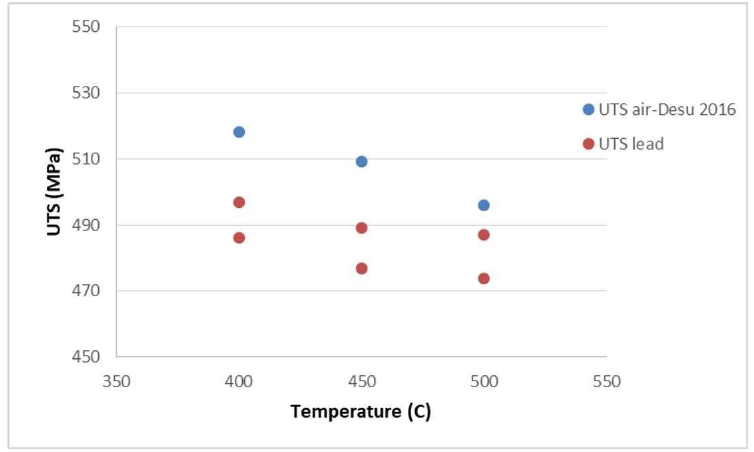
Figure 16. Effect of liquid lead on engineering stress.